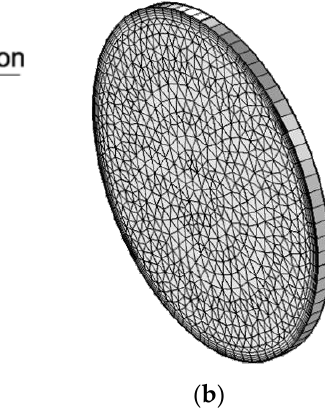
Figure 5. Comparison of Hagaen–Poiseuile flow and numerical result for non-Newtonian fluid.